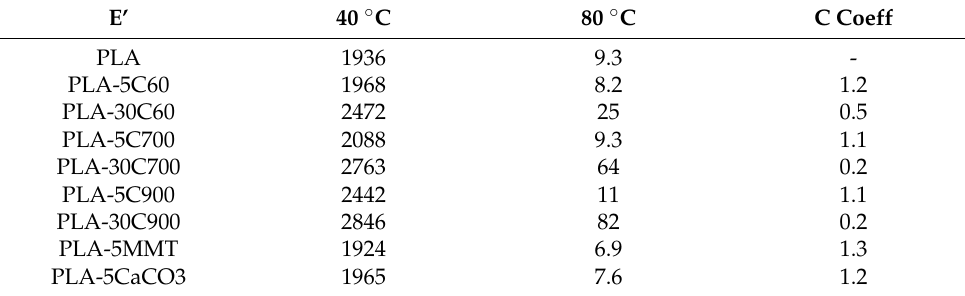
Table 3. Storage moduli and fibre reinforcement efficiency for all